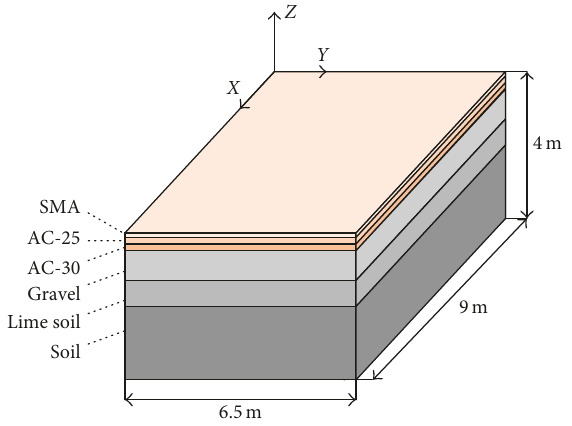
Figure 4: The 3D FE model of Table 2: The material parameters of asphalt concrete pavement. Thickness Material (cm)